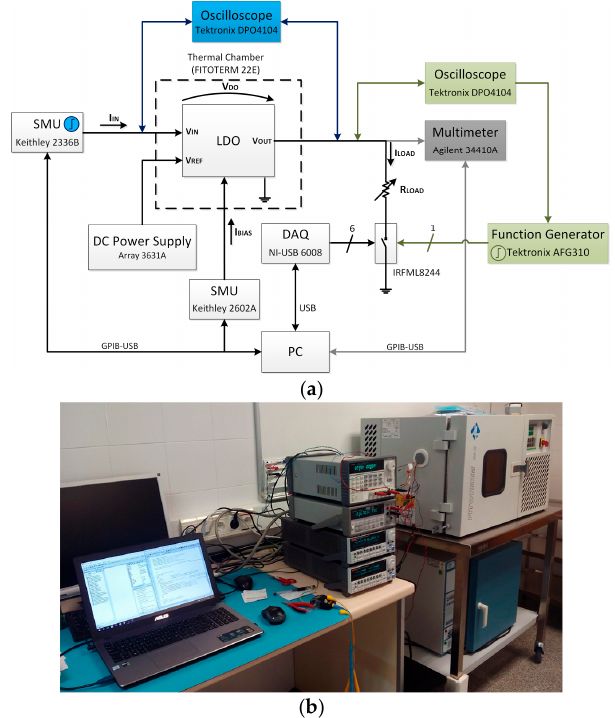
Figure 7. Measurement setup for the complete characterization of the LDO regulator: ( a ) block diagram of static (grey), transient load regulation (green) and transient line regulation (blue); and ( b ) experimental setup.